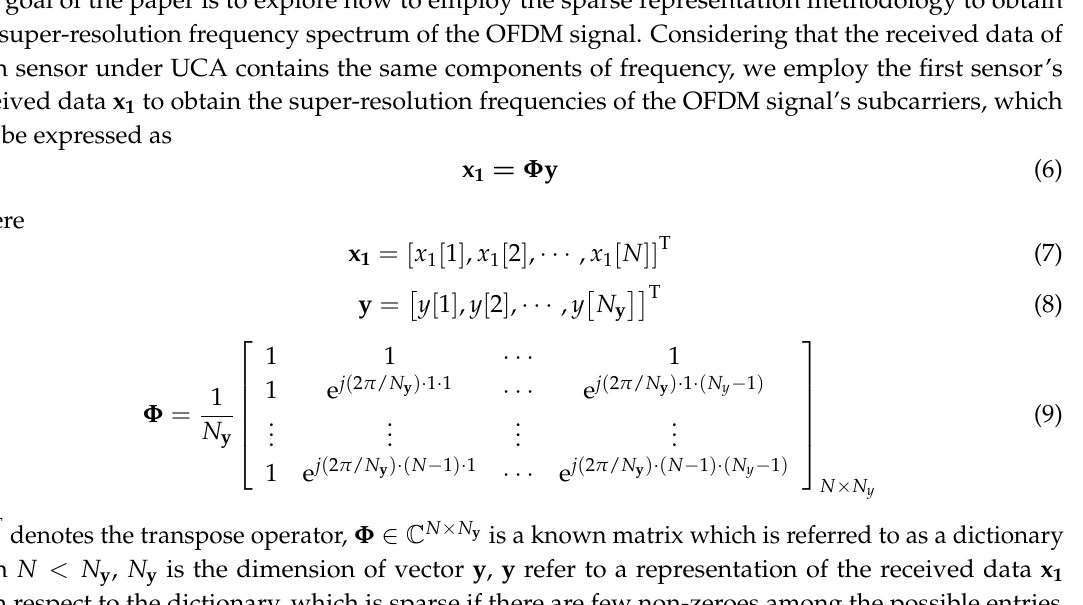
Figure 3. The effect of the subcarriers’ frequencies and phases on spectrum by performing FFT algorithm: ( a ) Subcarrier frequency spectrum ( ∆ ϑ = 0 ) ; ( b ) Subcarrier frequency spectrum ( ∆ ϑ = π ) ; ( c ) Received data frequency spectrum ( ∆ ϑ = 0 ) ; ( d ) Received data frequency spectrum ( ∆ ϑ = π ) ;